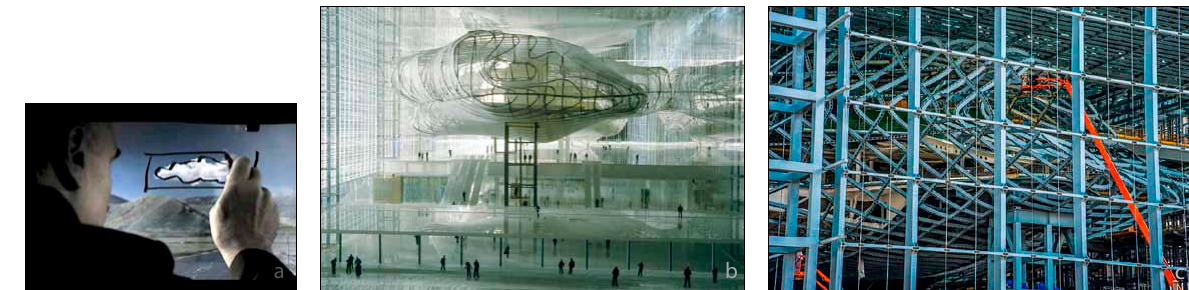
fig. 9. “la nuvola” Congress Palace